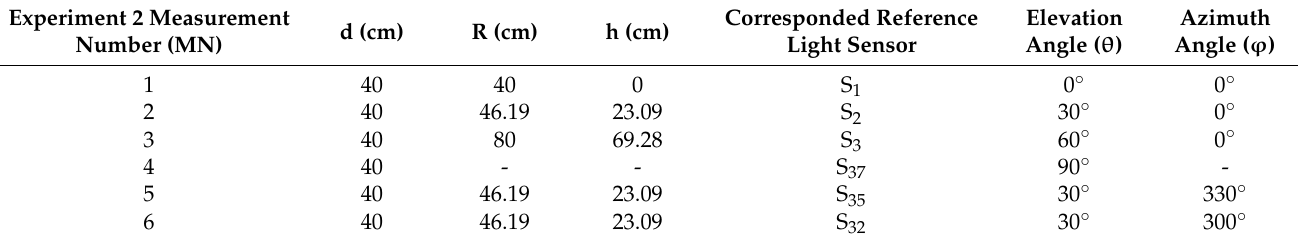
Table 2. Parameters of Measurements for Experiment